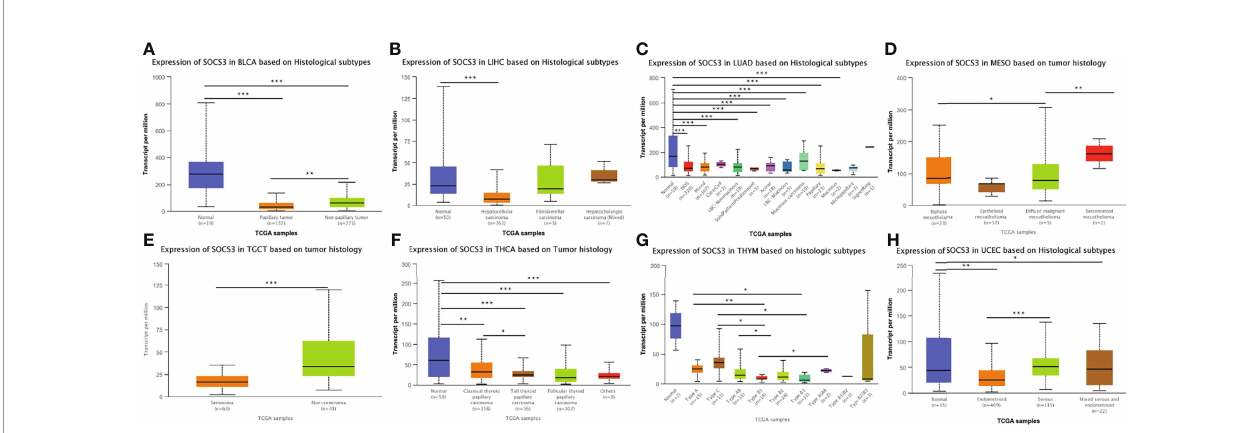
FIGURE 4 | The correlations between SOCS3 expression levels and histological subtypes in disparate cancers. This fi gure investigated that the expression levels of SOCS3 based on histological subtypes in various cancers, such as BLCA, LUAD, THYM, UCEC, LIHC, MESO, TGCT, and THCA, and there was signi fi cant